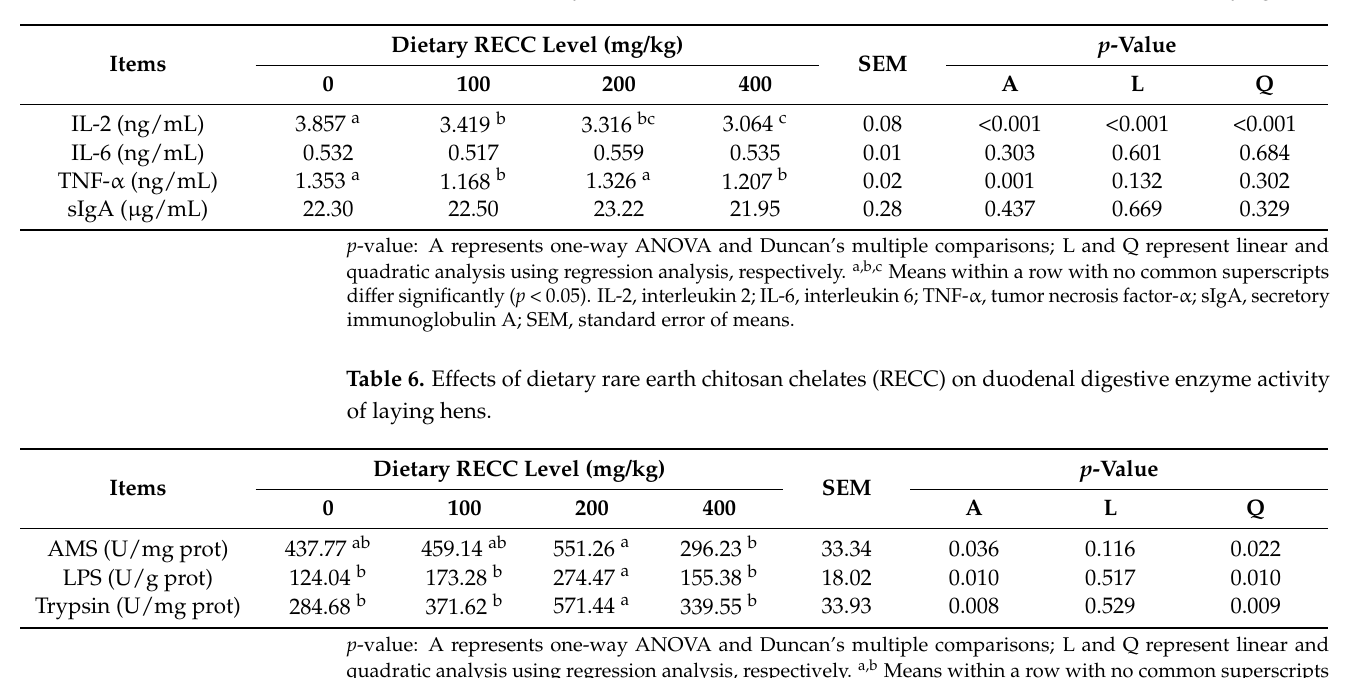
Table 5. Effects of dietary rare earth chitosan chelates (RECC) on intestinal immune indexes of laying hens.